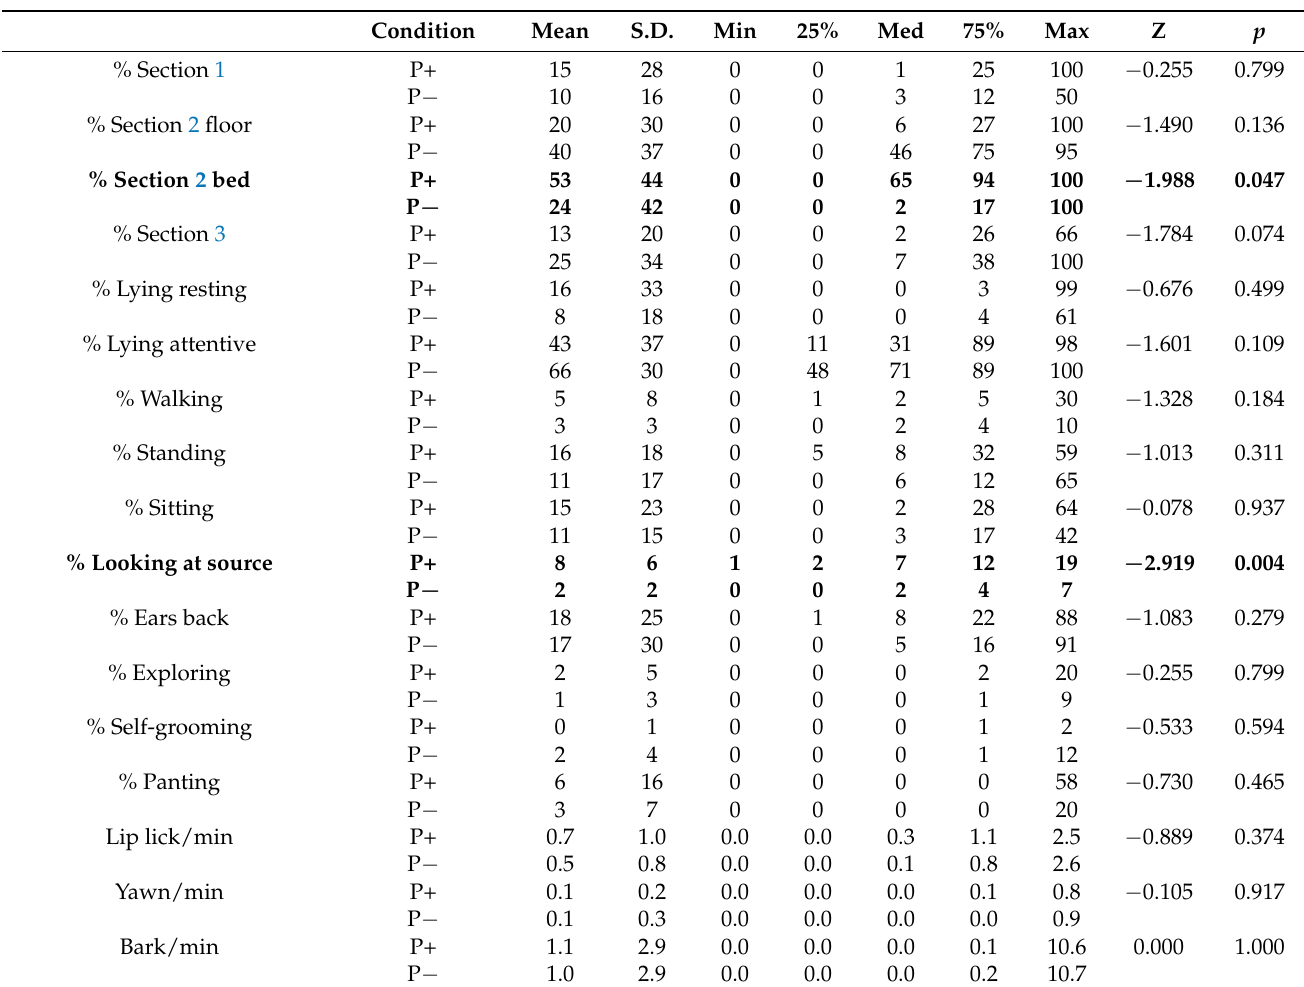
Table 4. Overview of the dog behaviour results, with mean, standard deviation (S.D.), minimum (Min), lower quartile (25%), median (Med), upper quartile (75%) and maximum (Max). Wilcoxon tests were used to compare the behaviours of the dogs between the two testing conditions (P+: person present or P − : person not present during the play back of the audio book). Significant differences are depicted in